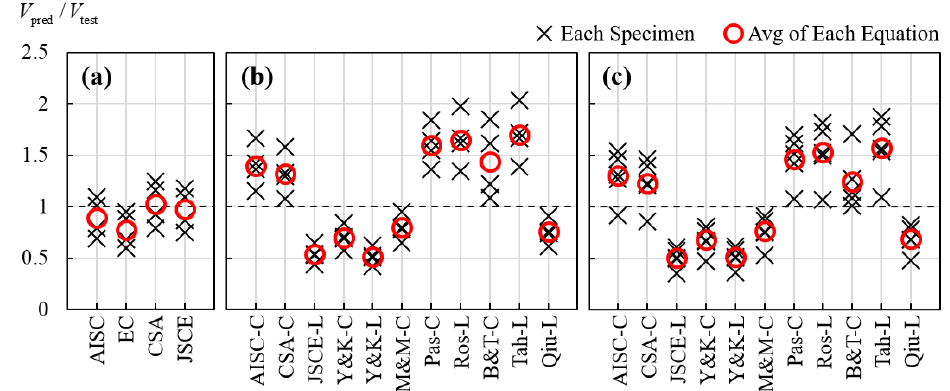
Figure 8. Comparison of Predictions to Tests: ( a ) Stud Anchors; ( b ) Fully-welded Channel Anchors (H-beams); ( c ) Partially-welded Channel Anchors